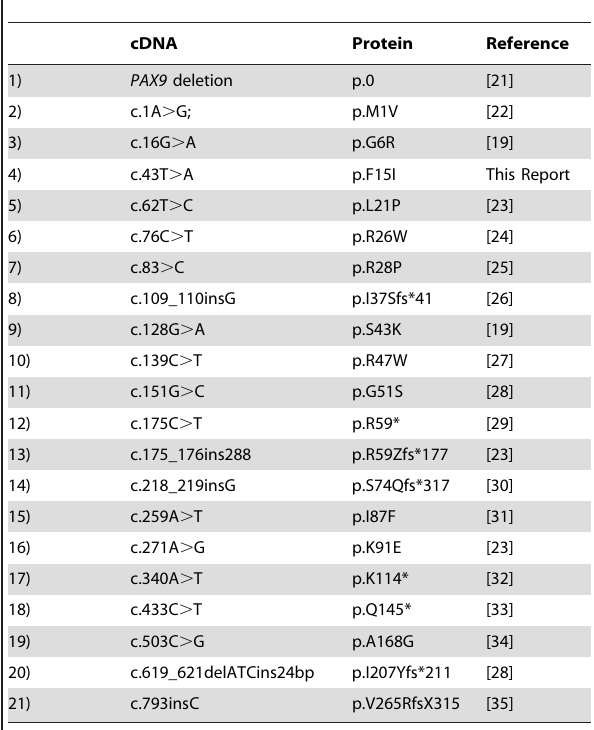
Table 1. PAX9 mutations causing familial tooth agenesis.